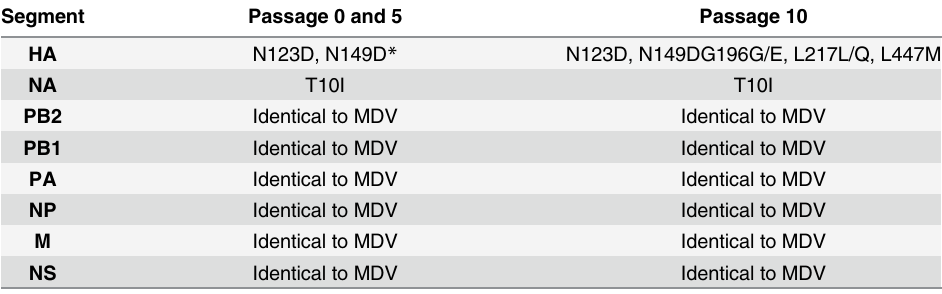
Table 3. Amino acid changes in A/Anhui/01/2013(H7N9)-CDC-LV7A before and after passaging in eggs.